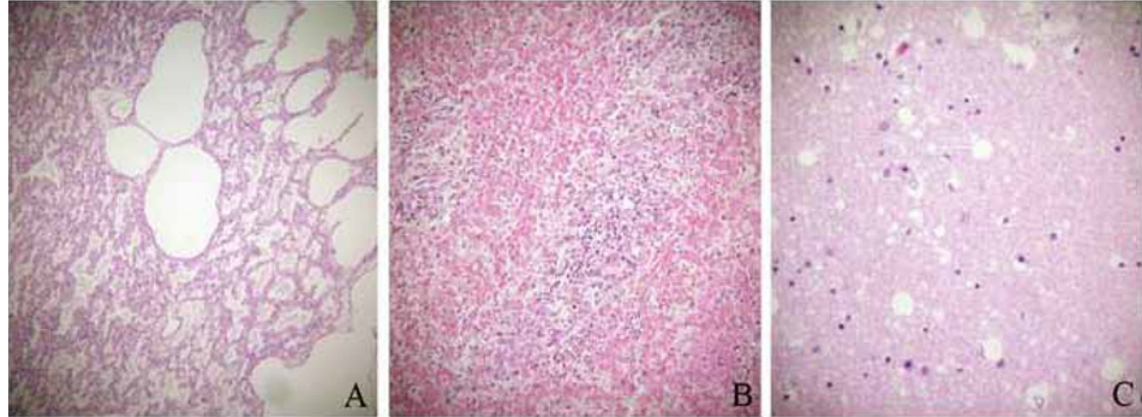
Figure 1. Histopathology in a patient died of capillary leak syndrome (HE staining, ×200). A: lung tissue: emphysema, focal atelectasis, peri- bronchial inflammatory cell infiltration; B: Liver: a large area of acute severe hepatic necrosis; C: brain: softening of the brain